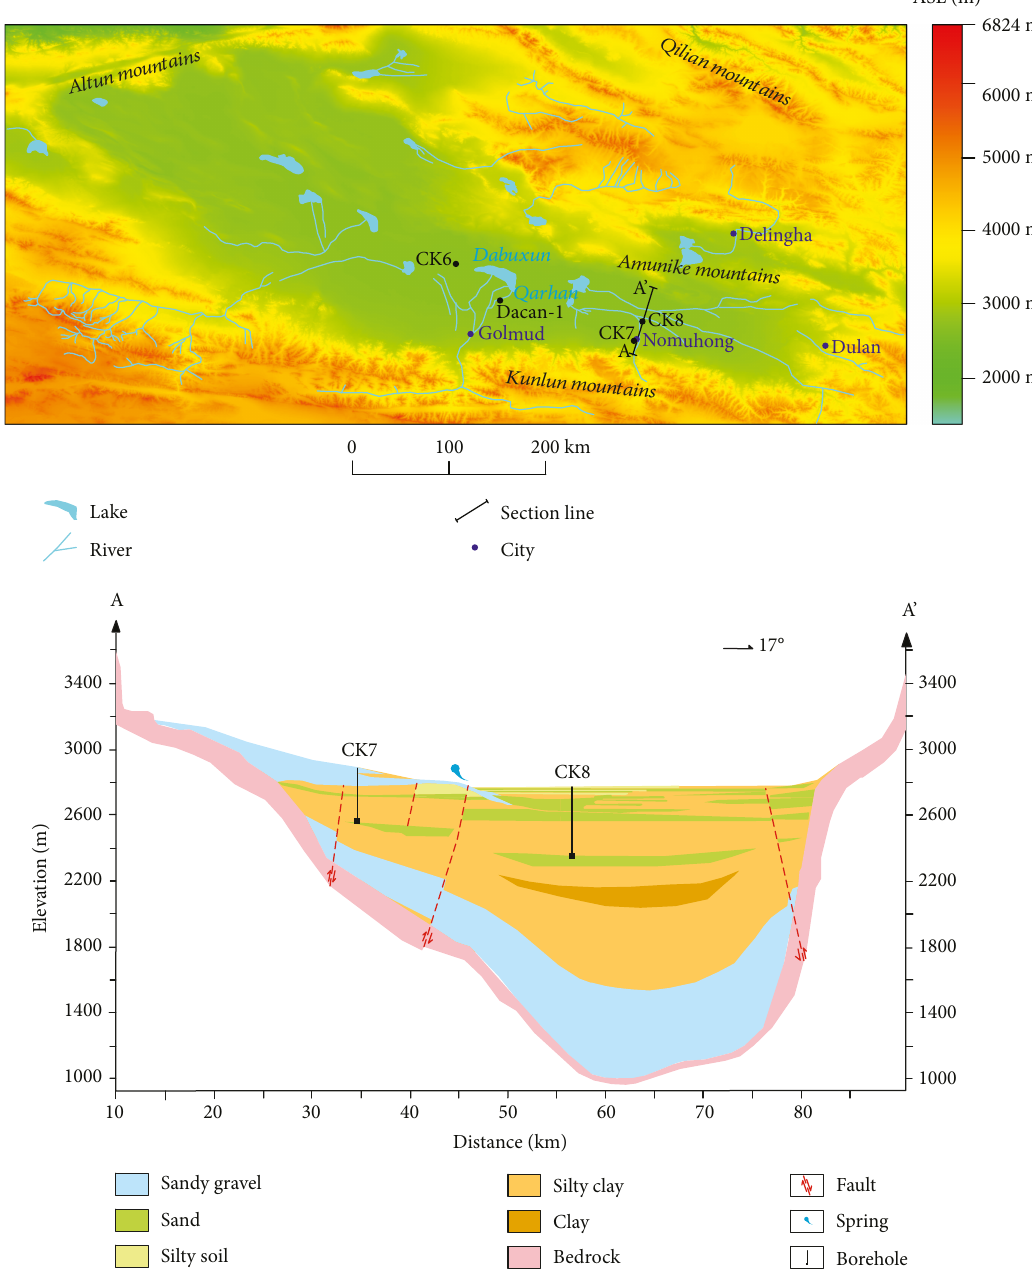
Figure 1: Location of the study area and the geological structure along a typical